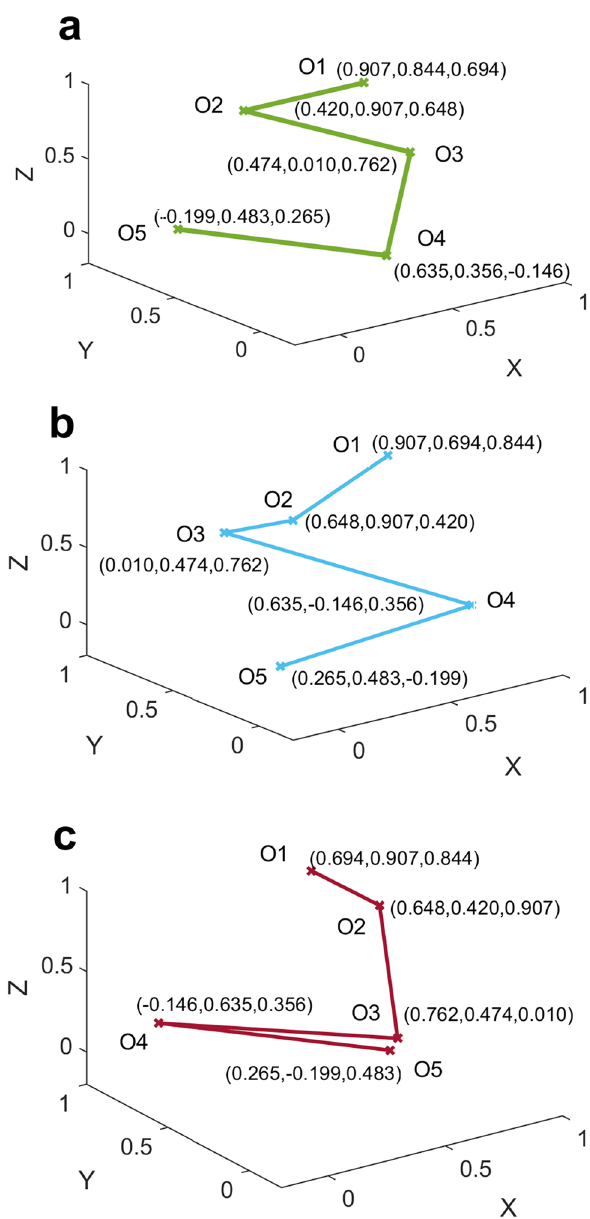
Figure 2. The three reference rdFC patterns. a Reference 1 b Reference 2 c Reference